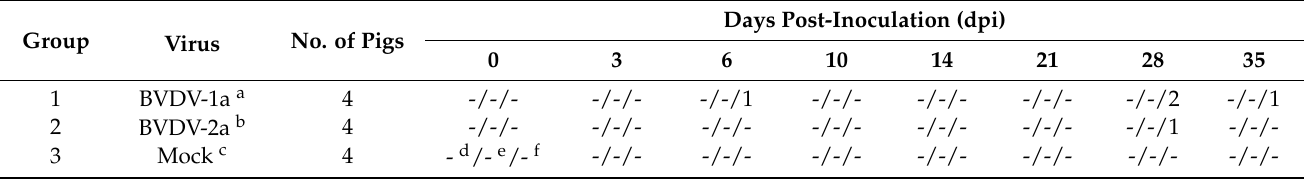
Table 1. Detection of bovine viral diarrhea virus in fecal, nasal, and blood samples from pigs. Days Post-Inoculation Group Virus No. of Pigs